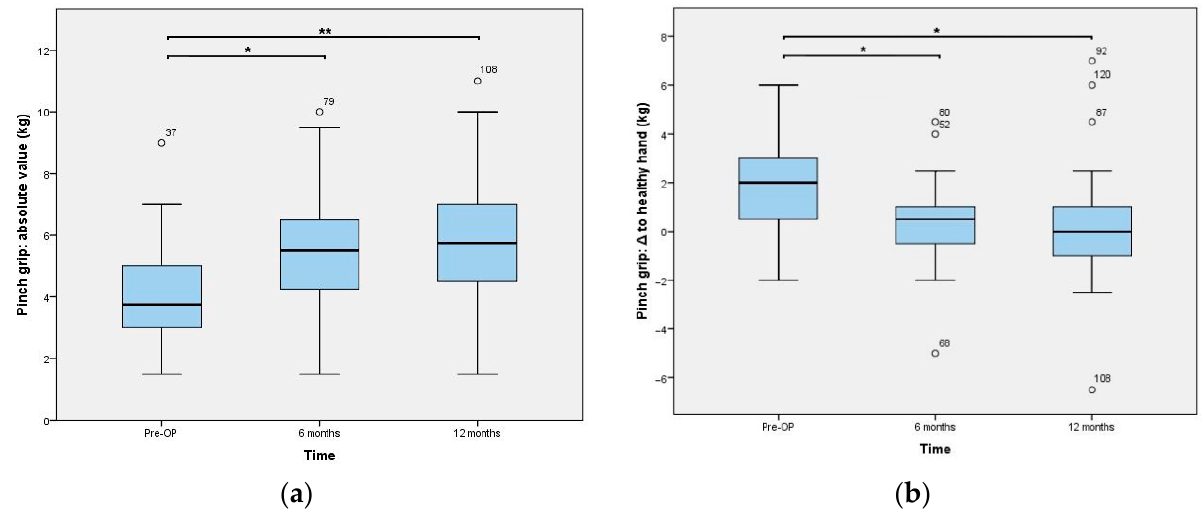
Figure 4. Visual analogue scale (VAS) values for pain. * indicating a p -value < 0.0001. Statistical outliers are presented using a small circle.